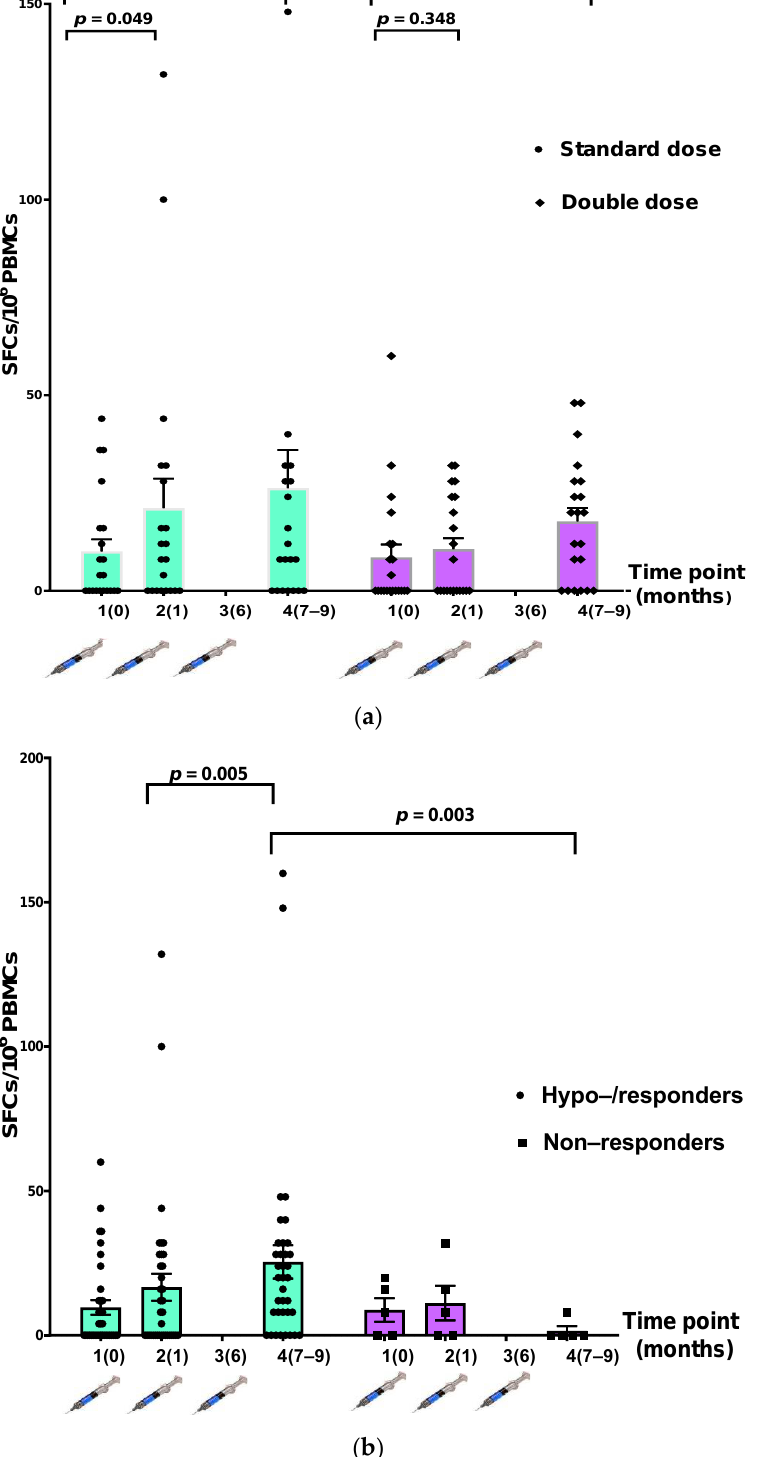
Figure 4. Comparison of T-cell-specific response to hepatitis B antigen measured using IFN- γ ELISpot assay at three time points. ( a ) The standard-dose (SD) (n = 21) and double-dose (DD) (n = 21) groups; ( b ) hyporesponders/responders (n = 37) and nonresponders (n = 5).